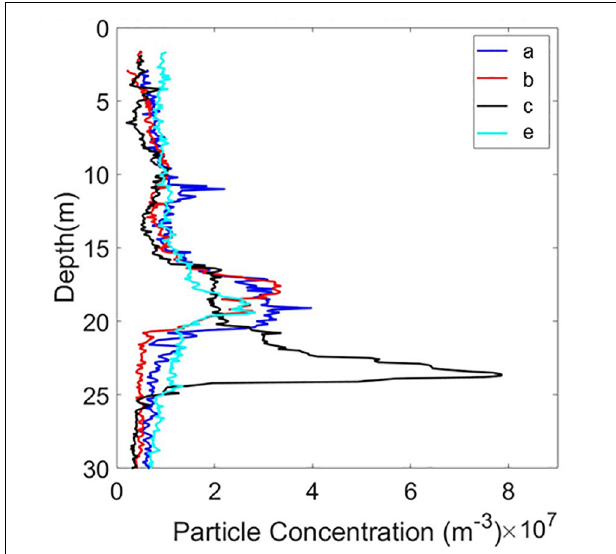
FIGURE 5 | Vertical distribution of particles detected from 4 profiles at the same station (I15) by the